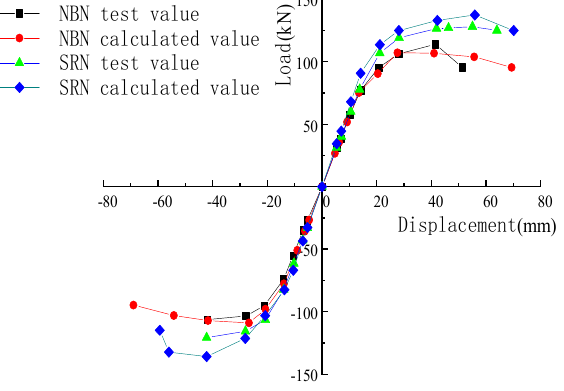
Figure 14. Comparison of hysteretic curves: ( a ) SRN; (b) NRN .